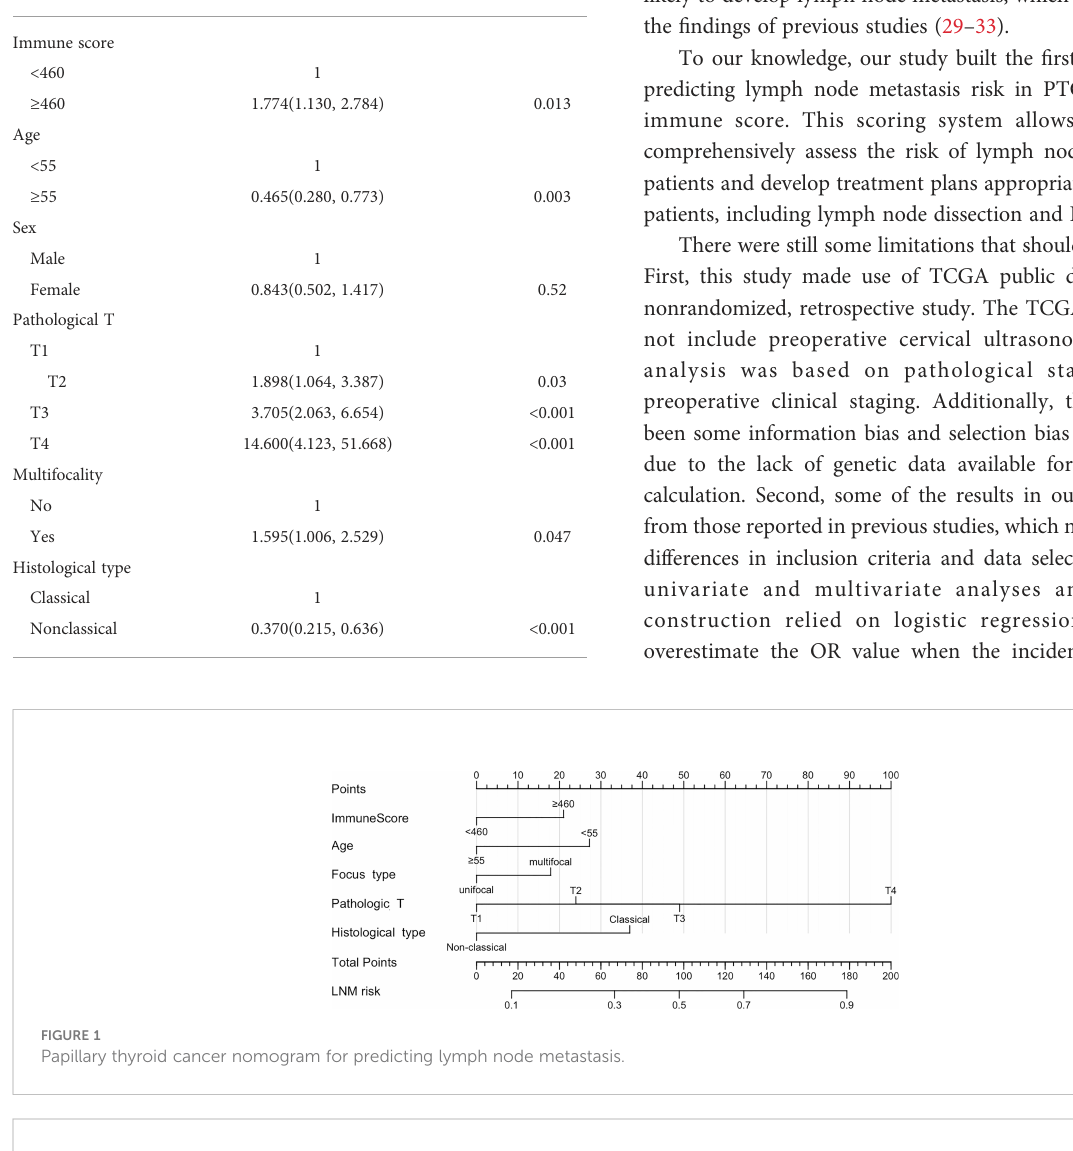
TABLE 3 Multivariate analyses of LNM among PTC patients according to clinical-pathological characteristics and immune scores. OR(95% CI) P value